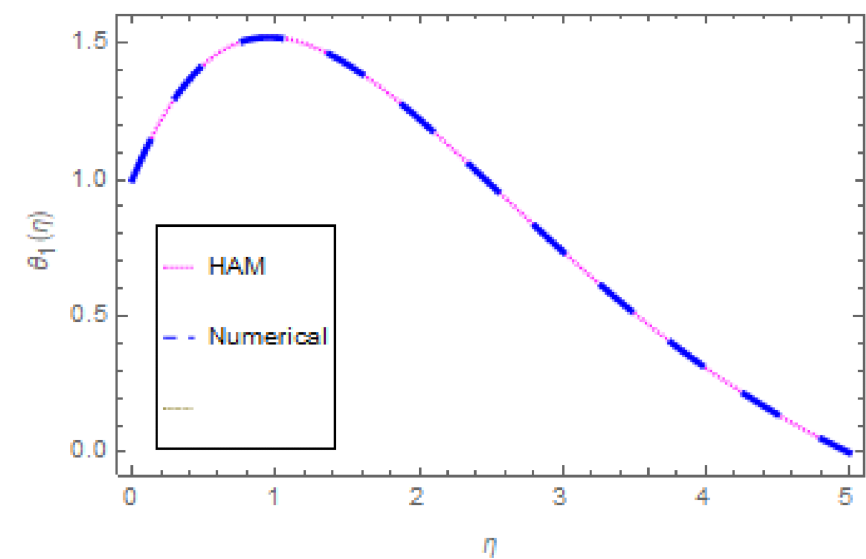
Figure 3. Comparison graph for temperature profile.